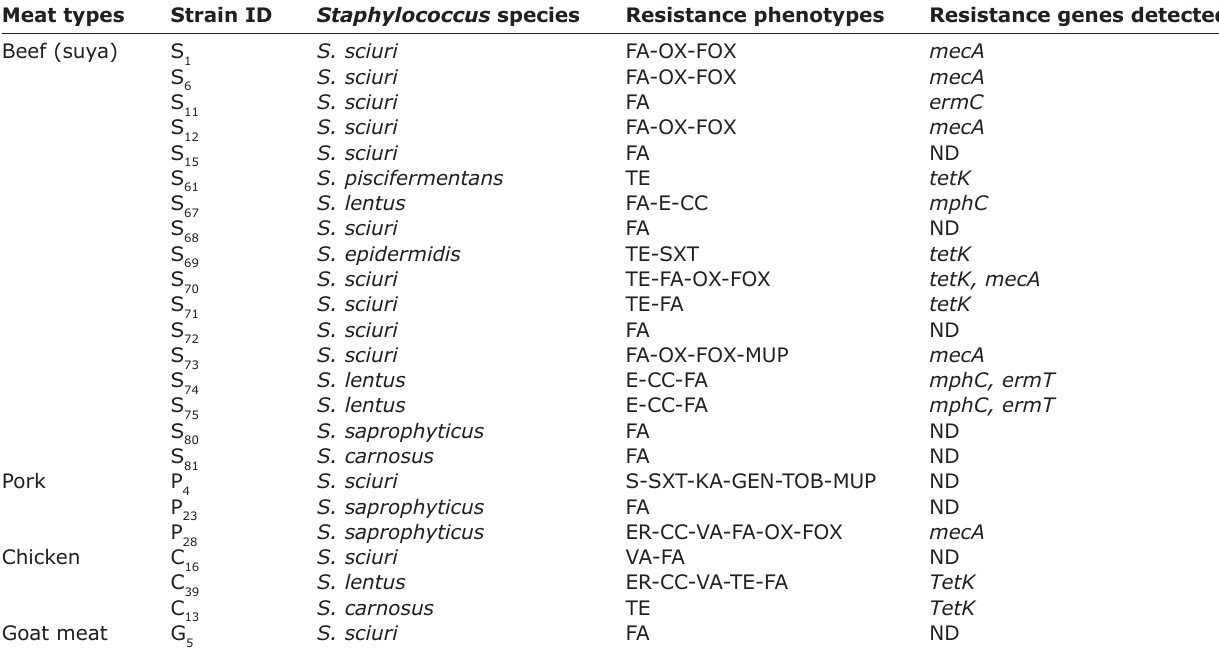
Table-6: Antimicrobial resistance genes detected from staphylococci isolated from different ready-to-eat meats. Meat